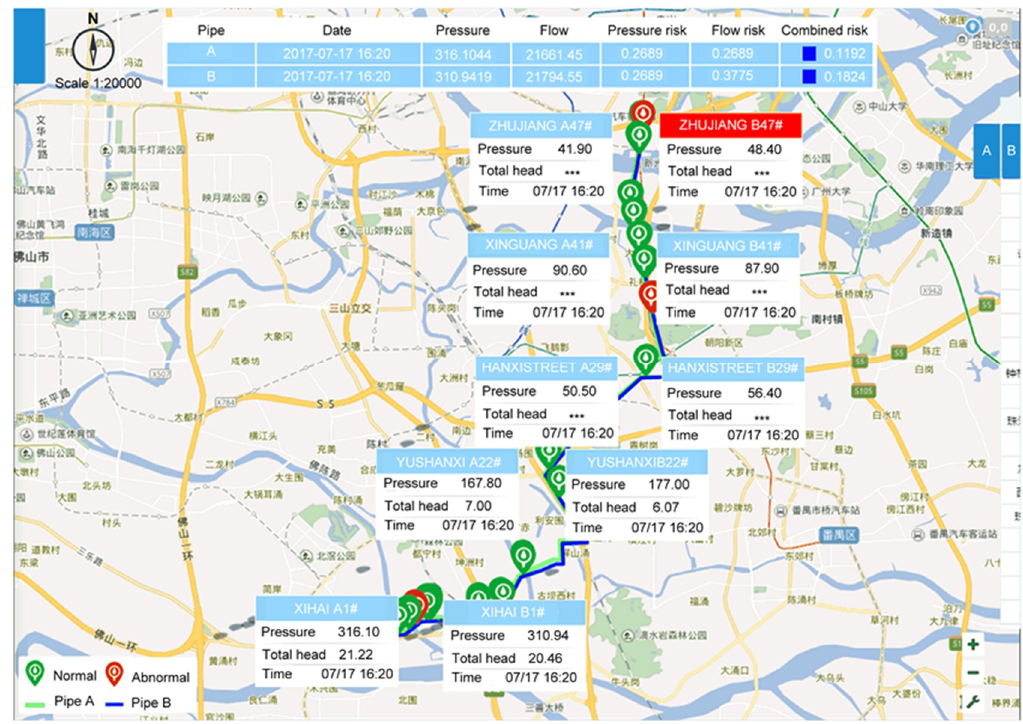
Figure 10. Pipe burst monitoring web page.